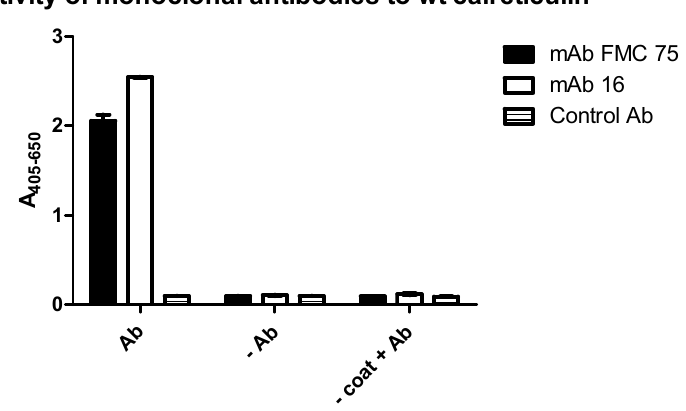
Figure 1. Antibody reactivity to wild-type calreticulin analyzed by enzyme-linked immunosorbent assay. Mouse anti-BAM was used as a negative control. − Ab functions as a control for the secondary antibody goat-anti mouse IgG. − Coat + Ab was added to verify specific reactivity.